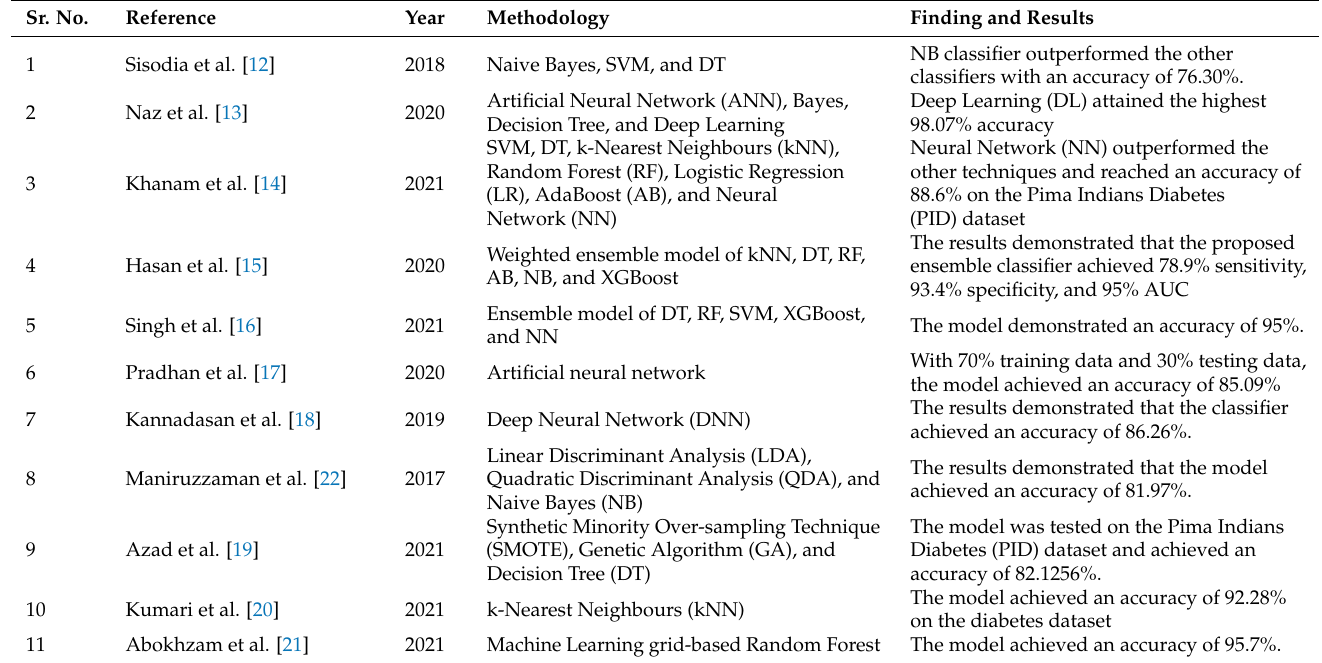
Table 1. Summary of machine learning techniques for diabetes